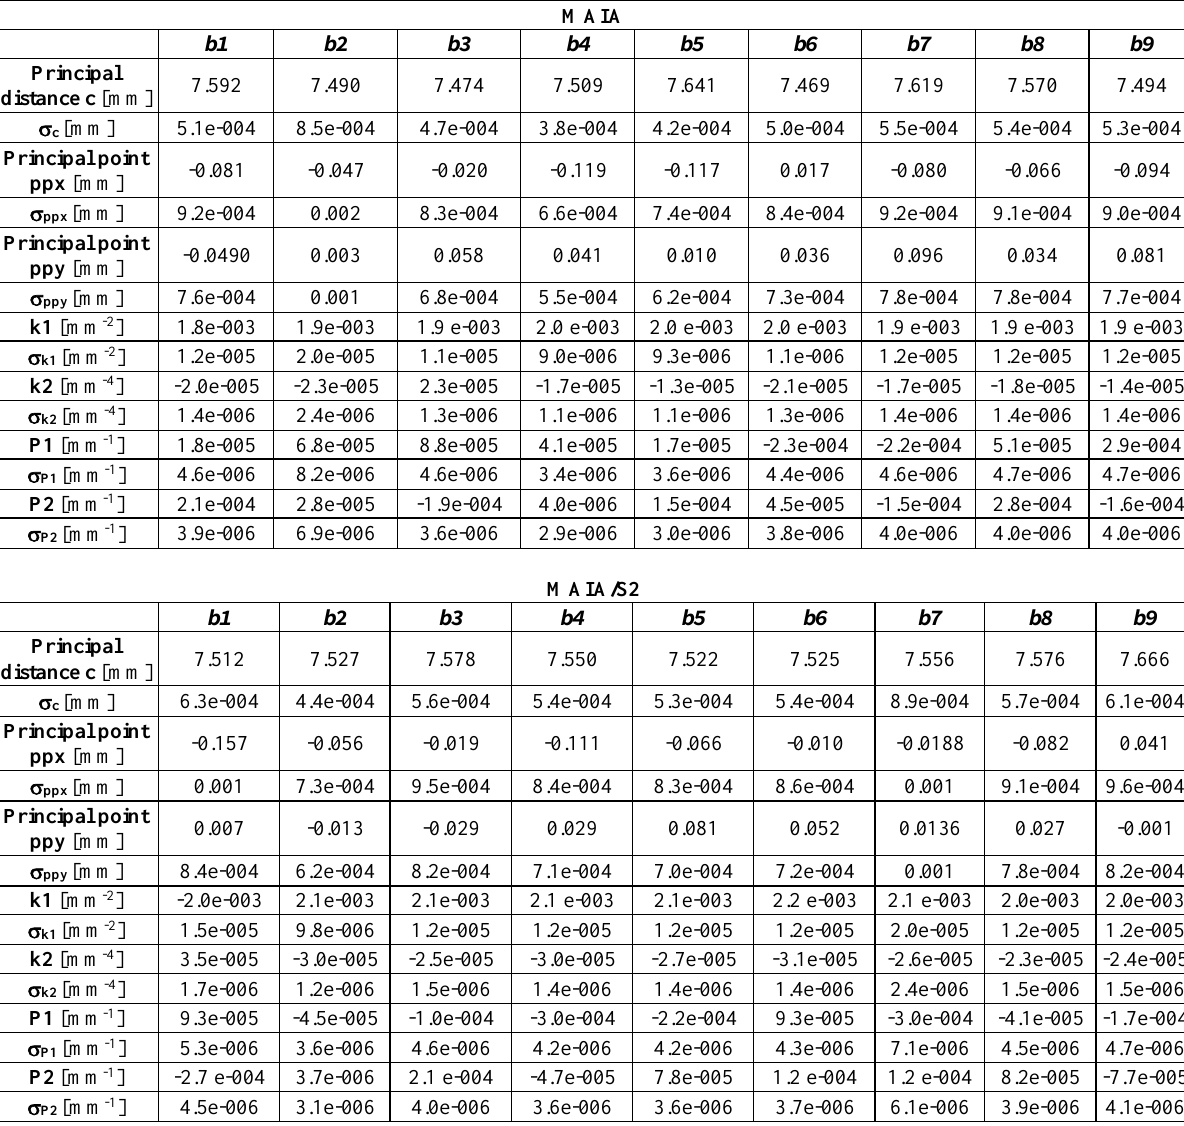
Table 2. Results of self-calibrating bundle adjustment for two MAIA